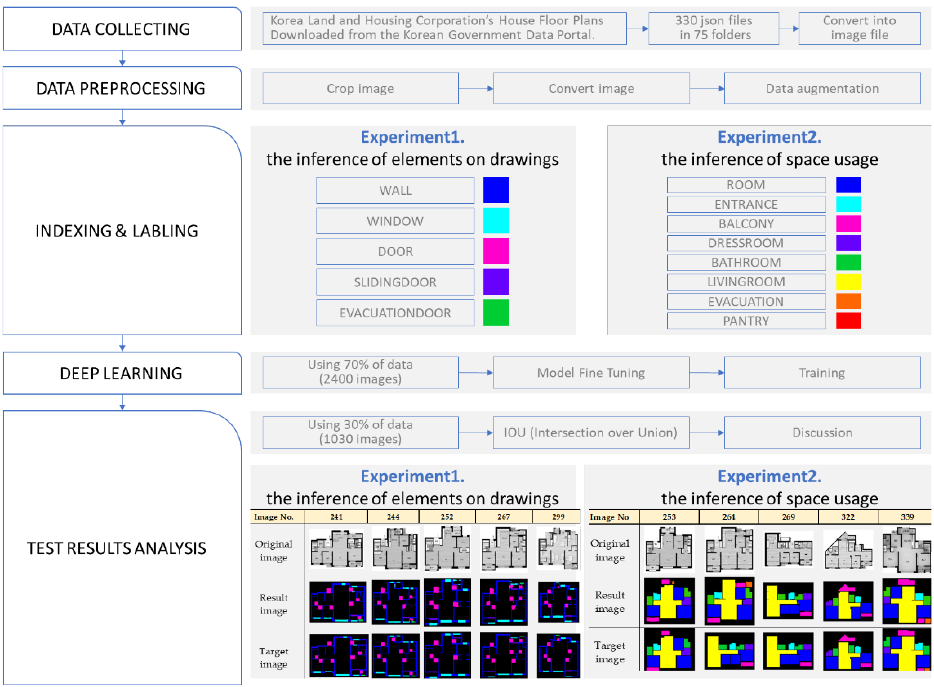
Figure 2. Flow of the research.